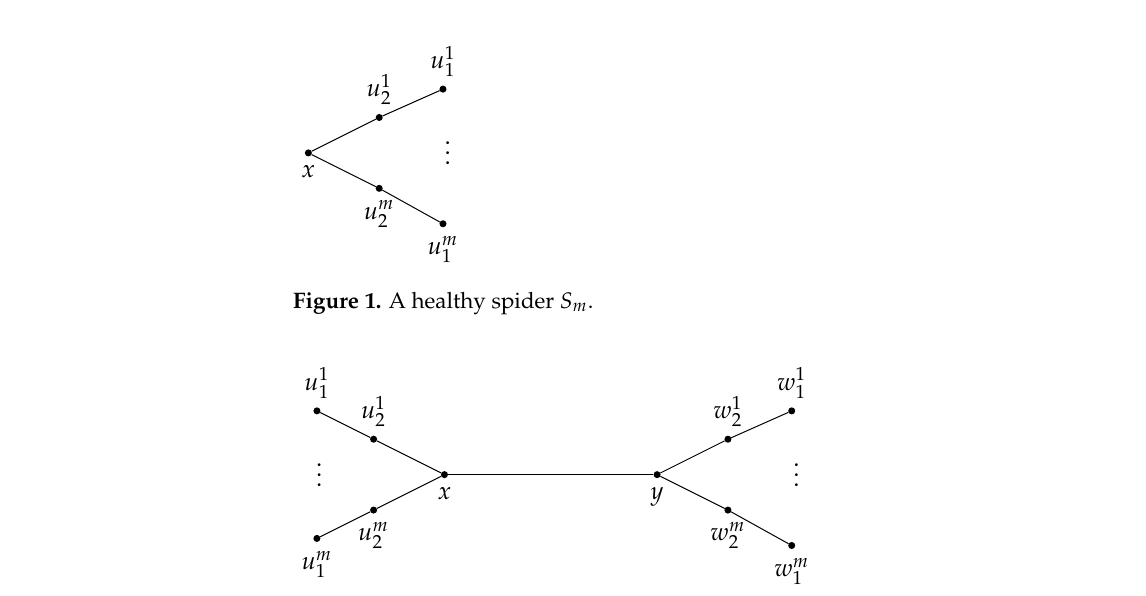
Figure 2. A tree T 1, m with sd γ